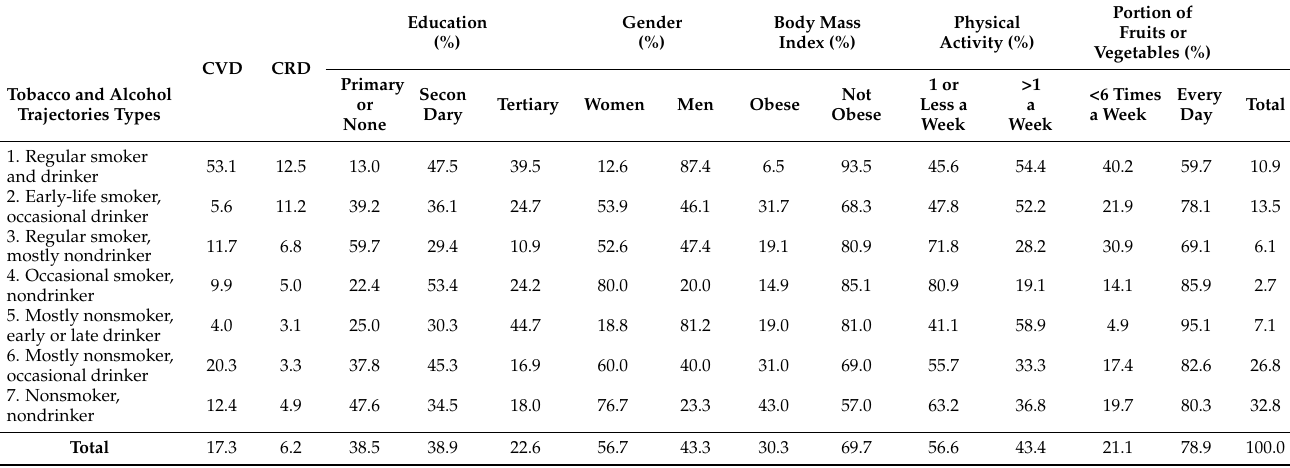
Figure 2. Sequence index plots of seven types of weighted lifetime tobacco and alcohol use trajectories. Table 2. Weighted distribution of CVD, CRD, education, gender, body mass index, physical activity, and frequency of fruits and vegetables by trajectory